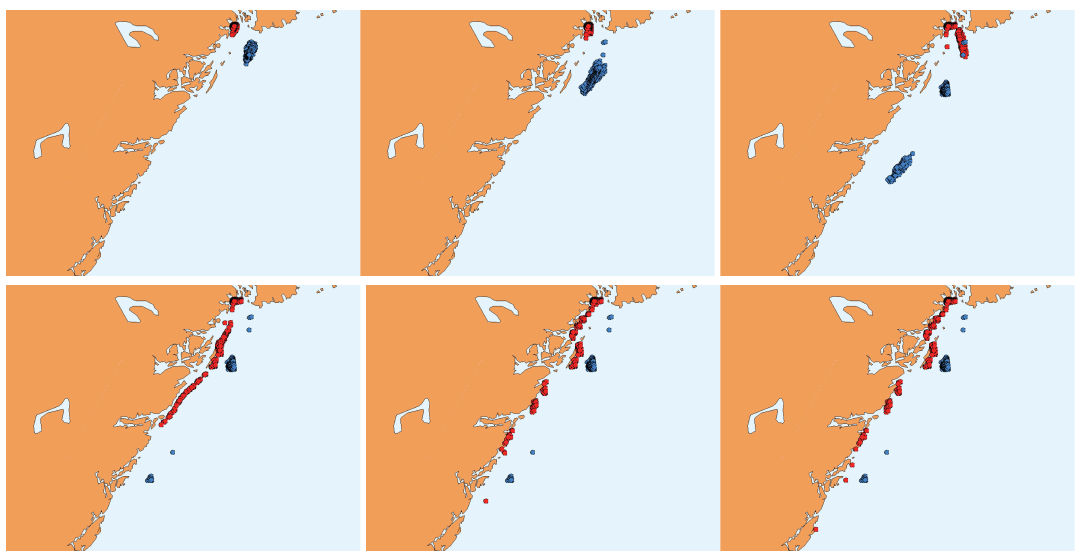
Fig. 8. The OD3D oil drift simulations using two different ocean models: red is for a 1.5km model and blue is for a 4km model. The figure shows the output 6, 12, 24, 36, 48, 60h after the initial release of oil. Note that the 4km (blue) model oil particles are beached well out into the sea due to low resolution: This model simulation also had to be initiated well out into the sea.